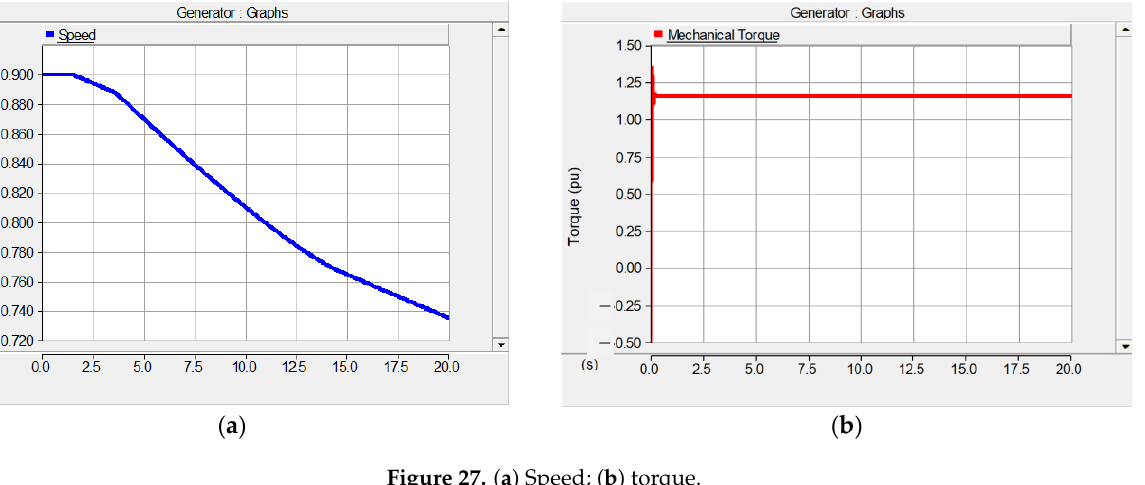
Figure 27. ( a ) Speed; ( b ) torque.